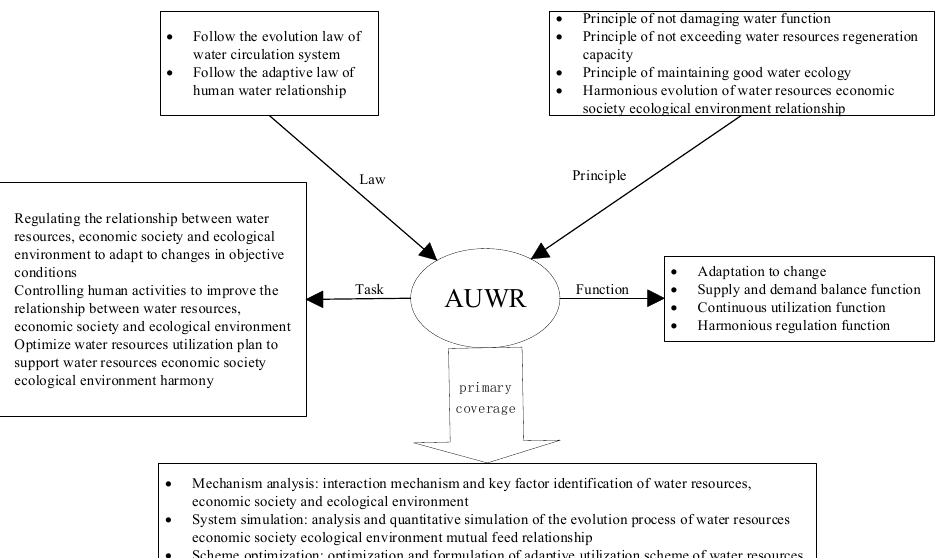
Figure 3. Framework of application rules for AUWR.